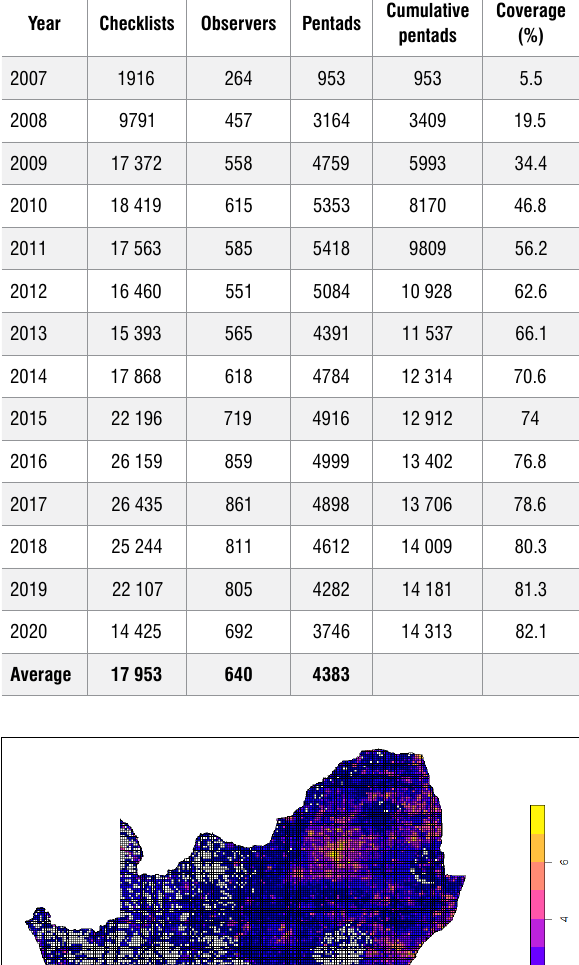
Annual SABAP2 milestones for coverage of South Africa, Lesotho and eSwatini in terms of the total number of contributing observers, with the total number of checklists contributed and the number of pentads. Percentage coverage is based on a potential 17 444 pentads for this geographical region.